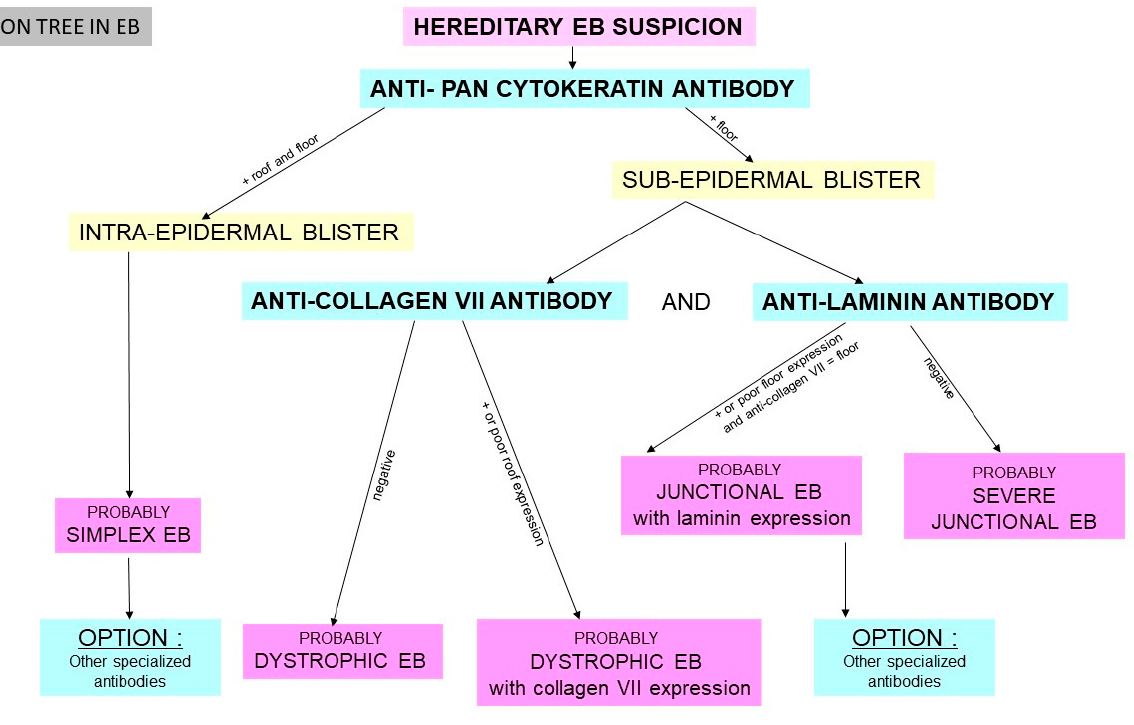
Figure 6. Decision tree.